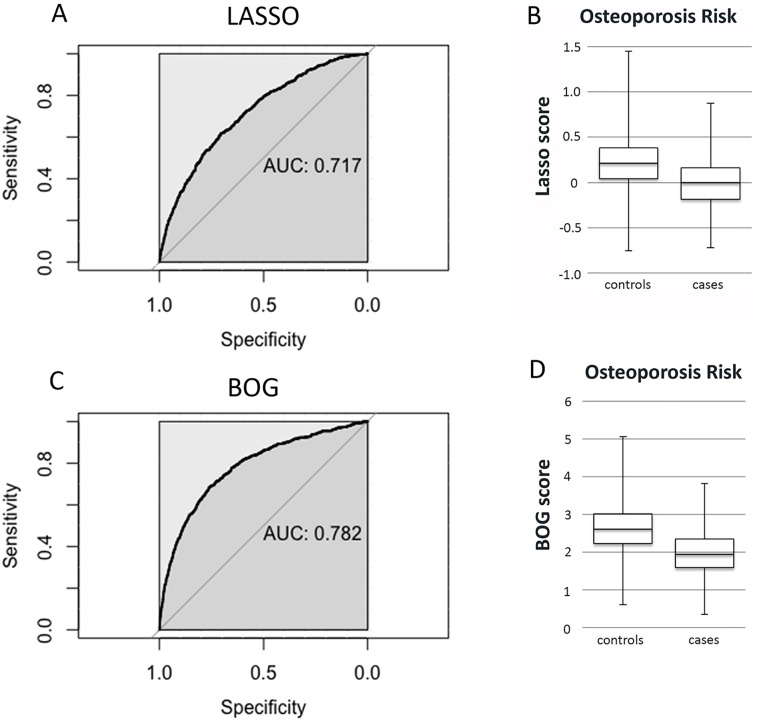
Receiver Operator and box plots for PRS’s for osteoporosis risk.A. Receiver Operator plot for the LASSO4 PRS for osteoporosis. B. Box plot for the LASSO 4 PRS. C. Receiver Operator curve for the BOG score for osteoporosis. D. Box plot for the BOG score. AUC; Area Under the Curve. Box plots show the maximum, first quartile, mean, third quartile and minimum scores for LASSO4 and BOG for osteoporosis cases and controls.